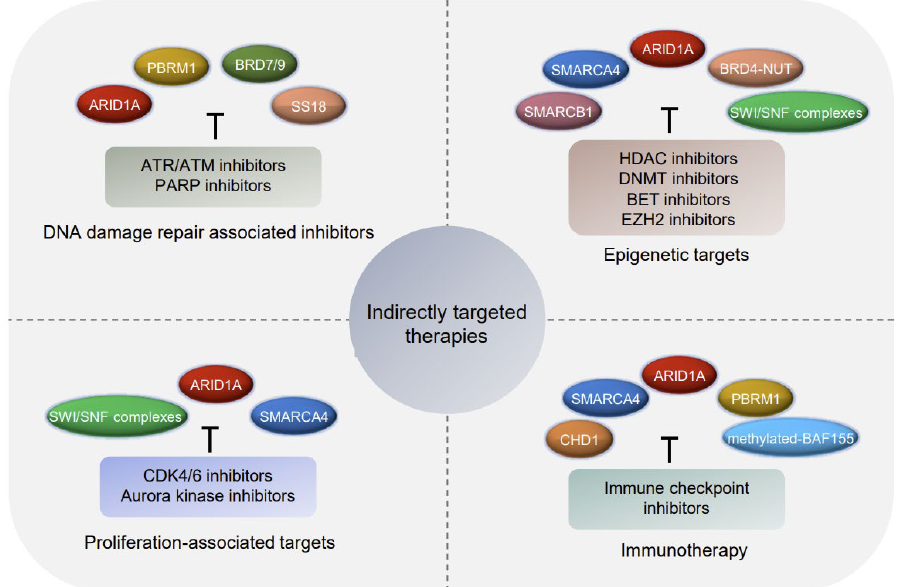
Figure 4. Overview of indirectly targeted therapies that exploit aberrant chromatin remodeling in cancer. Specific vulnerabilities in cancer cells caused by loss-of-function in a chromatin-remodeling situation might be targeted for cancer therapy. Available inhibitors for each target involved in the genetic defect’s vulnerabilities conferred by aberrant chromatin remodeling are listed.